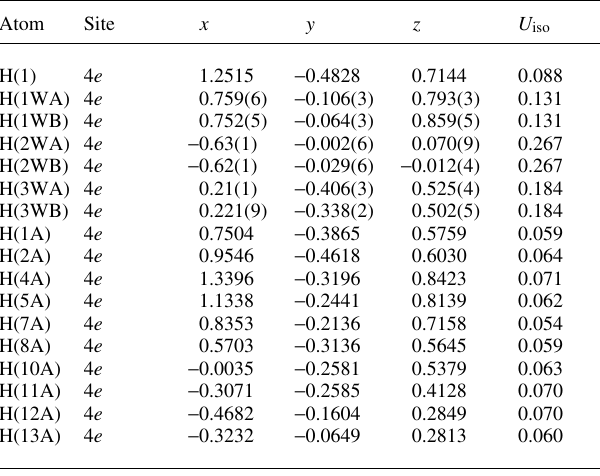
Table 2. Atomic coordinates and displacement parameters (in Å 2 )